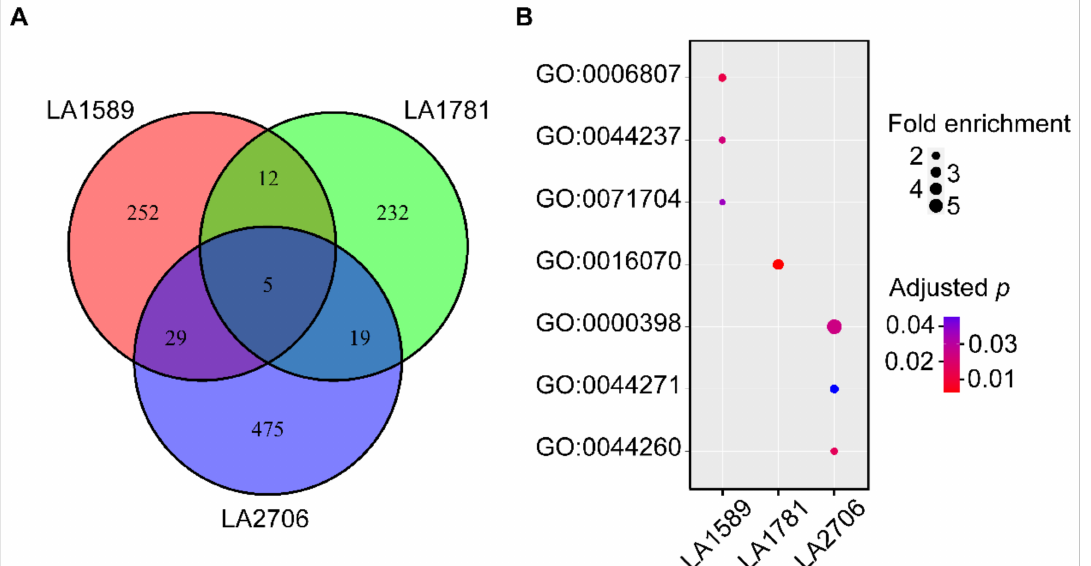
Figure 2. AS events in response to growth conditions . ( A ), A Venn diagram showing DAGs identified in the inflorescences of LA1589, LA1781 and LA2706 (Moneymaker) in response to changing growth conditions. ( B ), Gene ontology analysis of DAGs. DAGs were identified by comparison of AS events between open field and plastic greenhouse. GO:0006807, nitrogen com- pound metabolic process; GO:0044237, cellular metabolic process; GO:0071704, organic substance metabolic process; GO:0016070, RNA metabolic process; GO:0000398, mRNA splicing via spliceosome; GO:0044271, cellular nitrogen compound biosynthetic process, GO:0044260, cellular